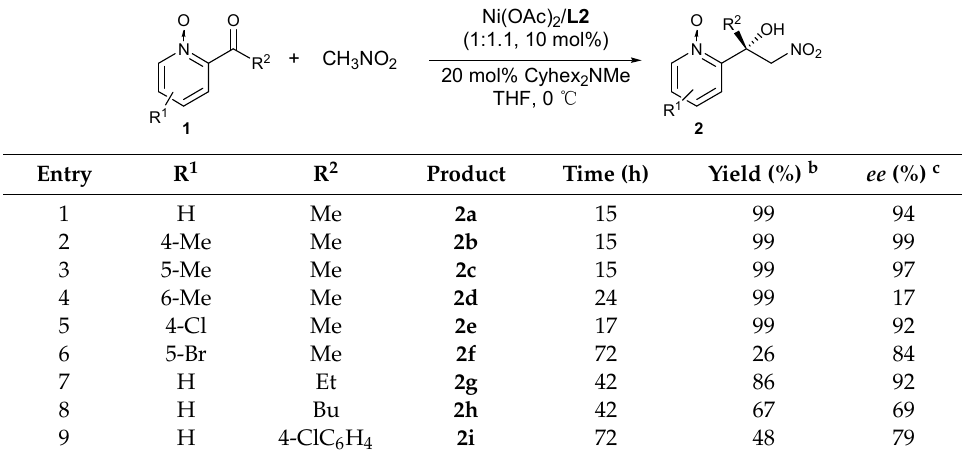
Table 3. Substrate scope for the asymmetric Henry reaction a .